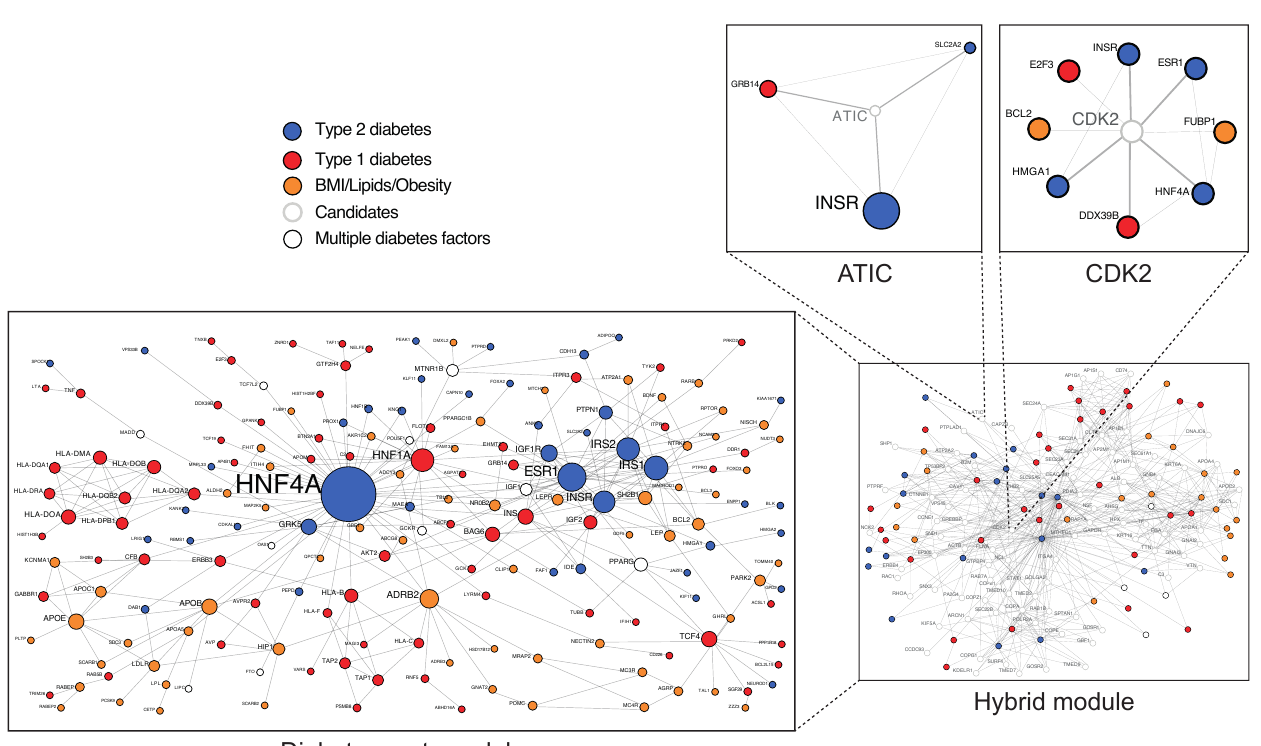
Figure 2. Diabetes-associated genes form a protomodule. 184 genes at risk of T2D are here validated in a single component proteins–proteins interaction network of 309 iterations called protomodule. The general topology of the protomodule is characteristic of a disease network with the presence of few central hubs of a large size, surrounded by numerous peripheral hubs of a smaller size. Expansion of protomodule (seeds) through physical interactions with gene products in IR-containing endosomal network (IREN) results to a hybrid module where each protein from IREN, connected to at least three “seeds” from the protomodule, is considered as a gene candidate (grey nodes) for T2D. Candidates were additionally validated using gene ontology analysis for subcellular colocalization with connected “seeds” from the T2D protomodule and experimental approaches. (Adapted from Boutchueng et al. PLoS ONE 2018 , 13 ,